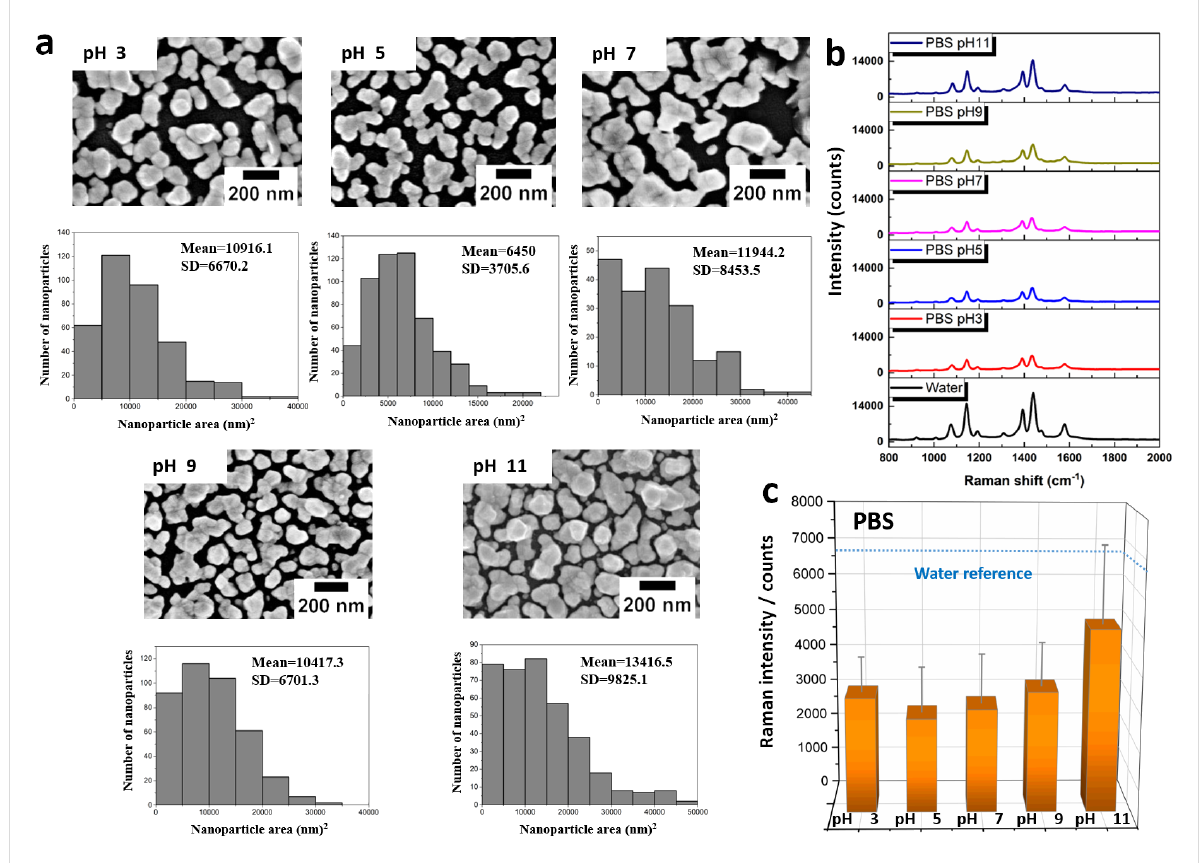
Figure 4: Stability test of microwave-fabricated SERS substrates in PBS solutions at different pH values. (a) SEM images of Ag nanoparticle coatings after 1 h of immersion in PBS and the corresponding particle size distributions. (b) SERS spectra of a monolayer of 4-ATP. The spectrum obtained after water treatment serves as a reference. (c) Error analysis of the 1078 cm − 1 marker peak which is attributed to the electromagnetic field enhance- ment mechanism [29]. The blue dotted line marks the Raman intensity level obtained for 1 h of water